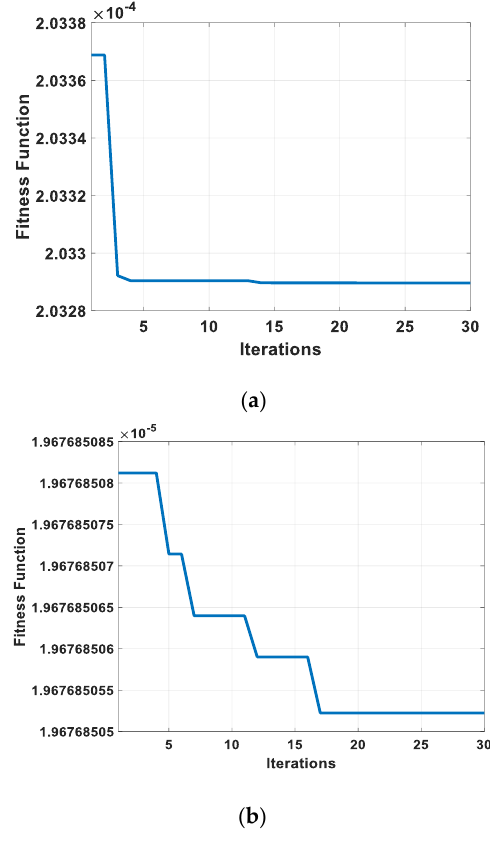
Figure 9. Convergence curves of the MPA algorithm for ( a ) ULC-PIDF and ( b ) ULC-fuzzy PIDF controllers. Table 3. optimal performance and gains of various controllers in terms of fitness.